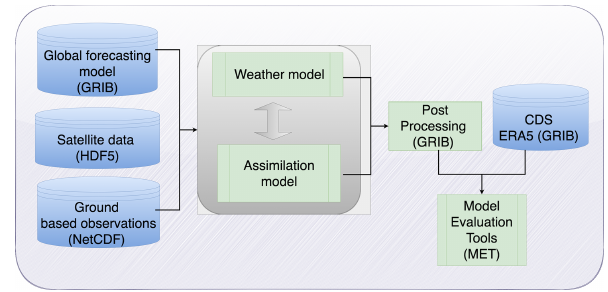
Figure 3. Weather forecasting model architectural